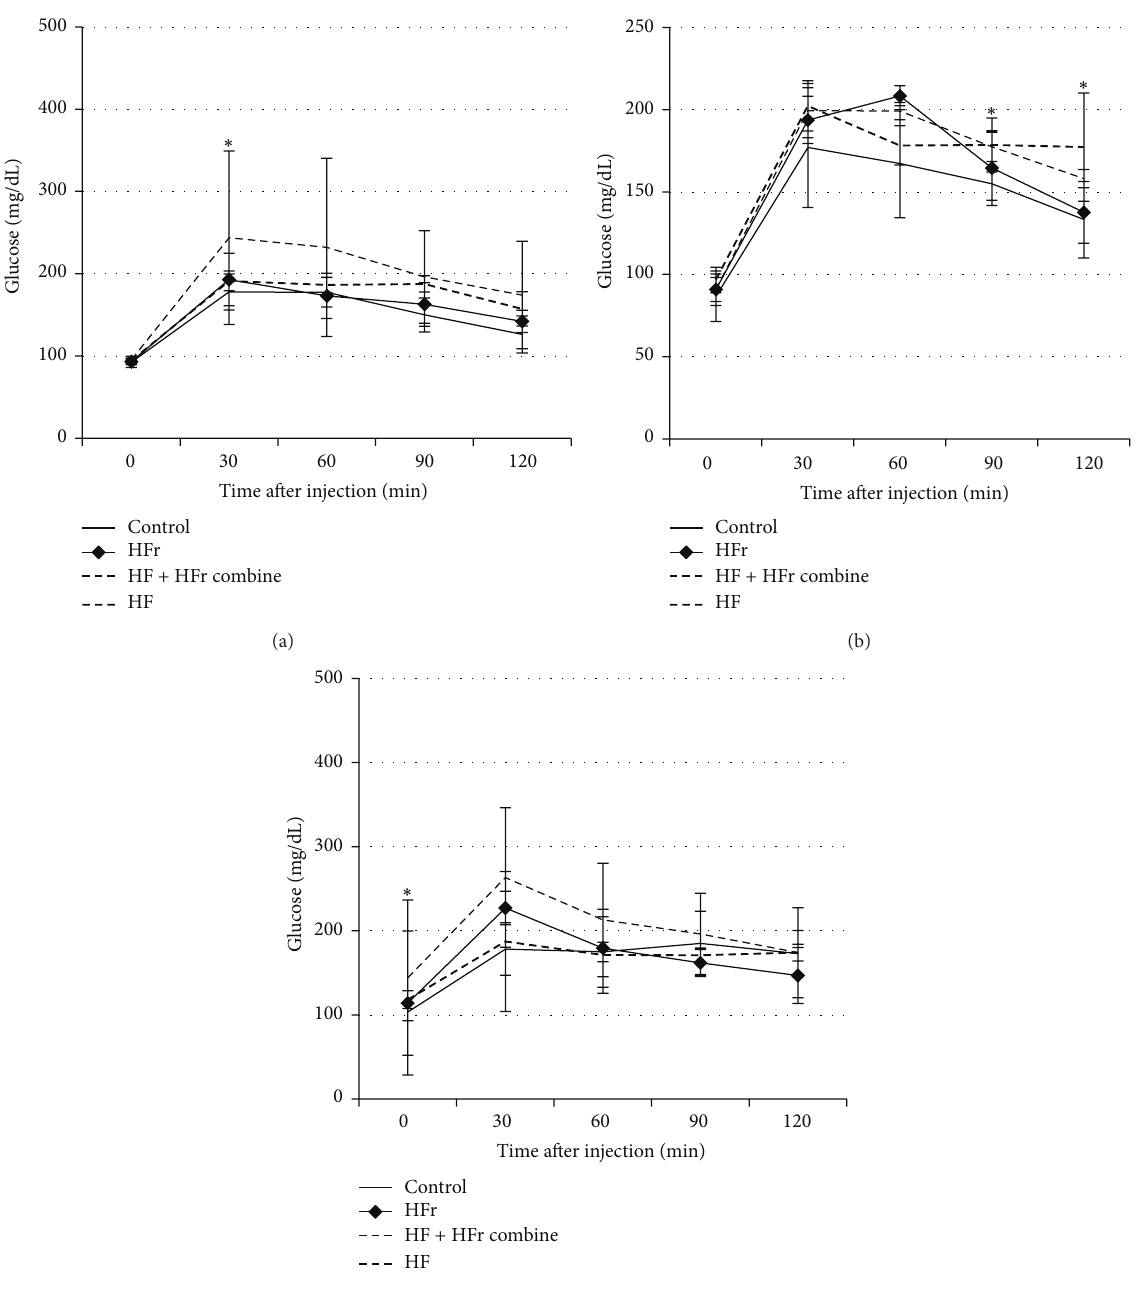
Figure 3: Effect of control, high-fat, high-fructose, and combination diet groups on insulin sensitivity. Blood glucose levels during the oral glucose tolerance test: 12 weeks (a); 16 weeks; (b) 20 weeks (c). ∗ 𝑝 < 0.05 by